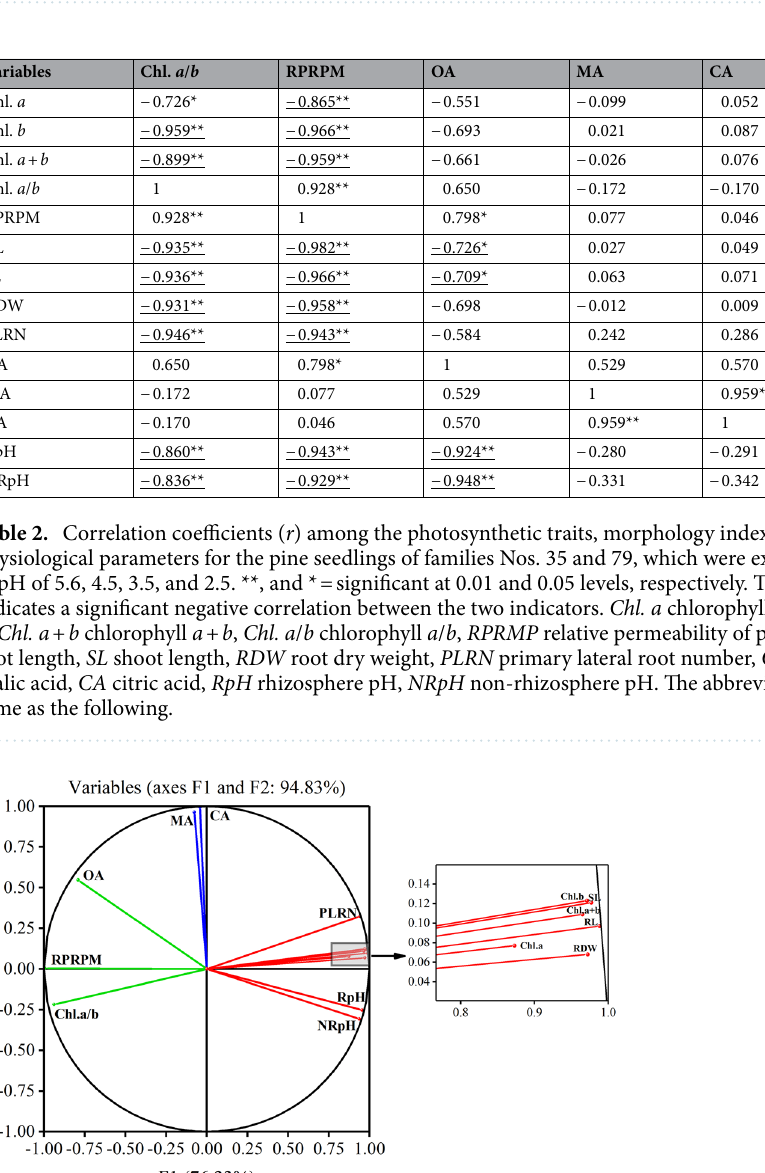
Table 1. ANOVA results of root organic acids secretion and soil pH of Masson pine exposed to the SAR (at 95% confidence level) (n = 3). SS is the sum of squares, DF is the degrees of freedom, and MS is the mean square.